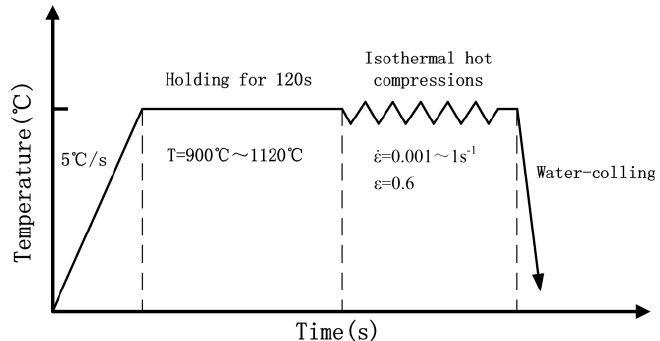
Figure 2. Flowchart of the GH4169 superalloy hot compression experiment.